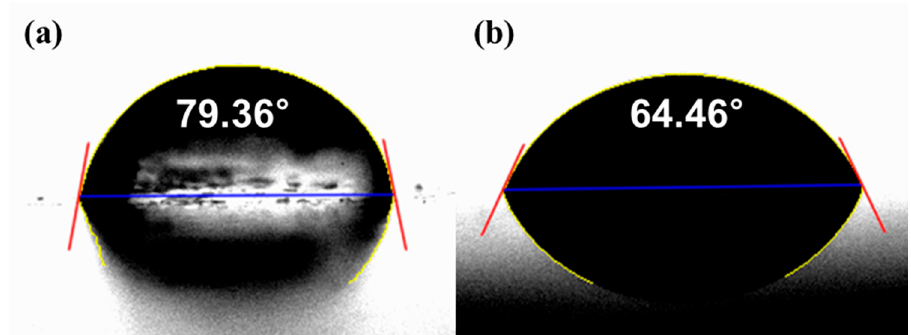
Figure 10. Contact angle between DIW and ABS-like resin; ( a ) after 3D-printing and ( b ) after sanding for 2 min. for 2